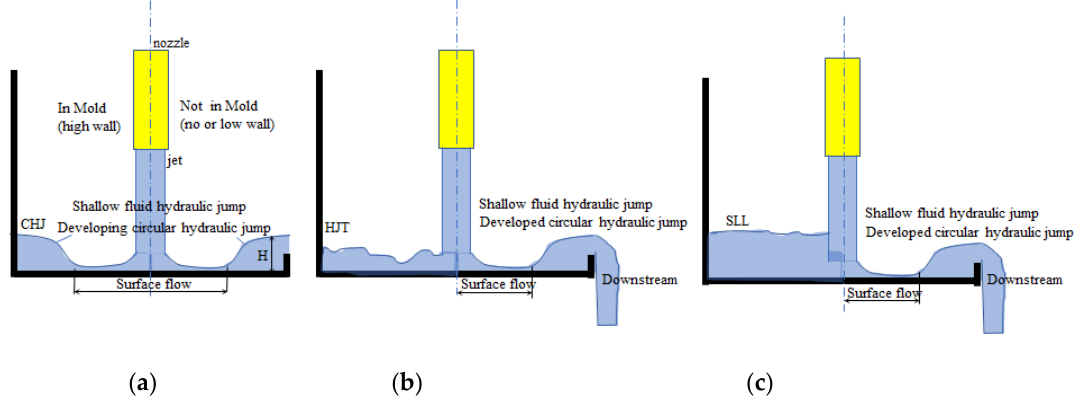
Figure 2. Schematic of hydraulic jump evolution in and not in the mold; ( a ) CHJ; ( b ) HJT; ( c ) SLL. Besides, the hydraulic jump behavior changes due to liquid jet impingement on patterned surfaces with alternating microscale-ribs and cavities [21]. Then, different spring and iron chips arrangement on the dummy bar in the filling process should cause the change of the hydraulic jump.